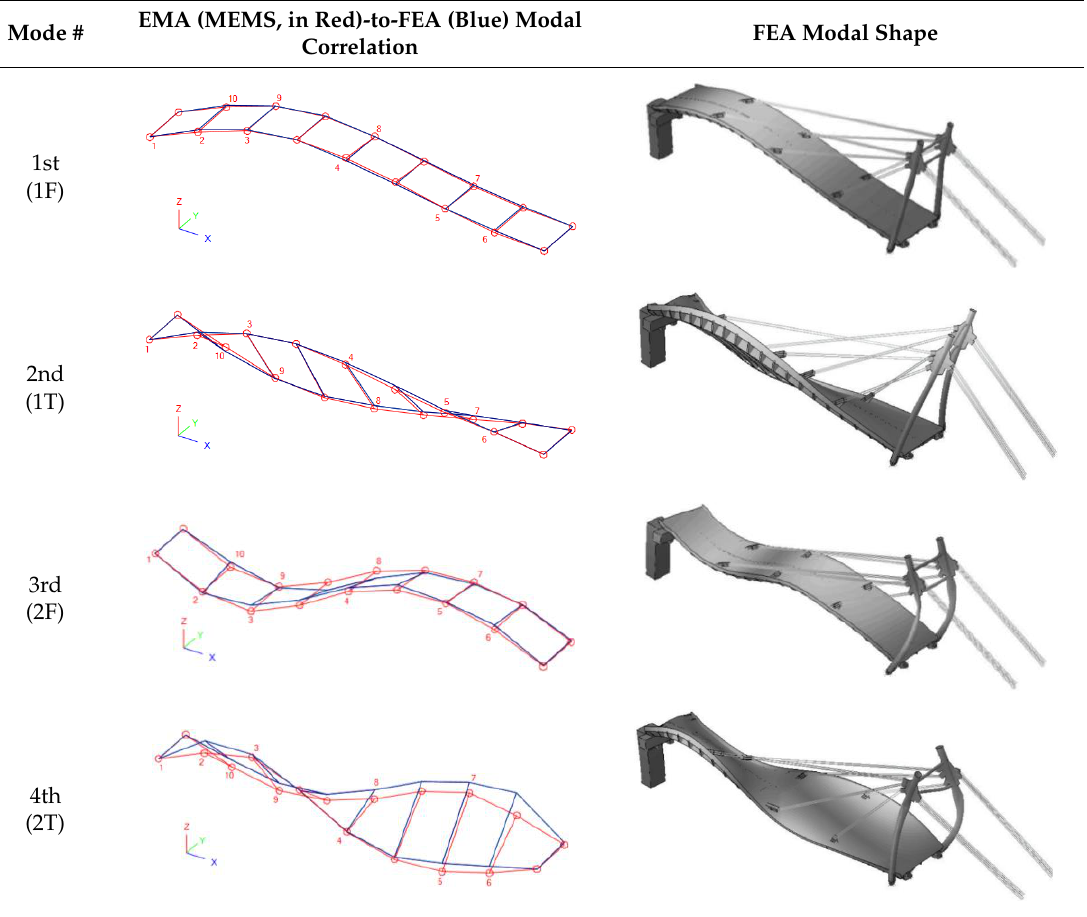
Table 5. EMA (MEMS)-to-FEA modal correlation and vibration shapes (3D axonometric view). Mode #